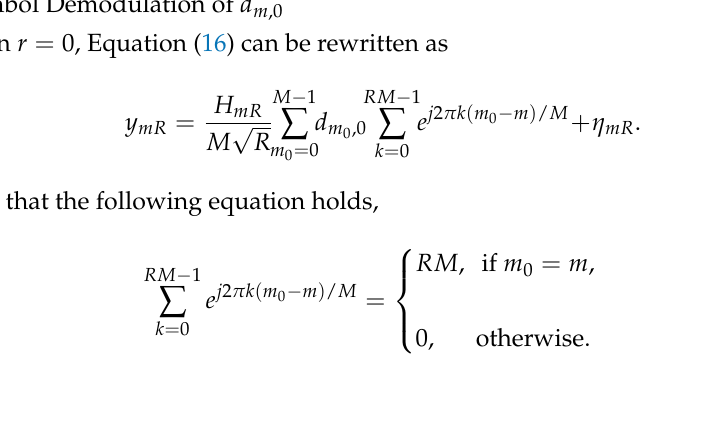
with respect to r , r ∈ [ 0, R − 1 ] , R = 0 , r